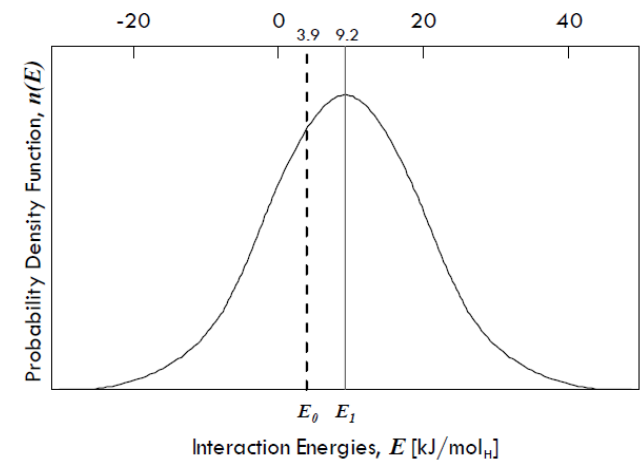
Figure 9. Gaussian distribution of site energies for hydrogen in nano-crystalline palladium. Adapted from Mütschele and Kirchheim [31].